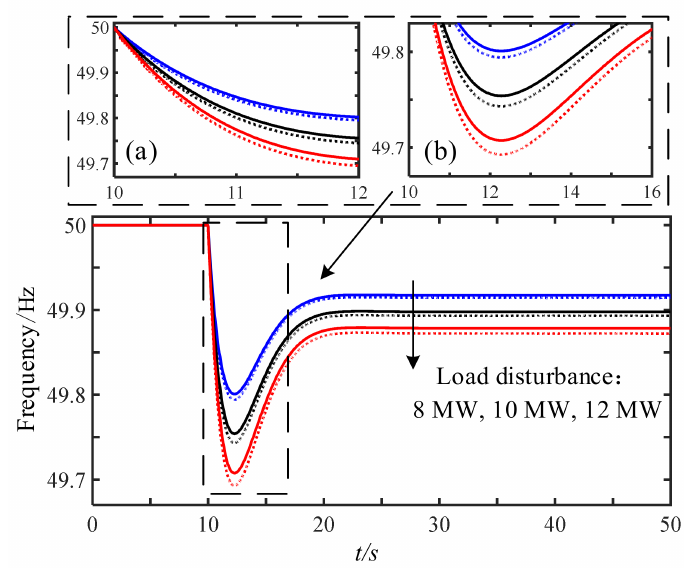
Figure 13. The influence with (solid line)/without (dashed line) asynchronous motors on the system frequency characteristics when the load disturbance keeps increasing. ( a ) The maximum rate of change of frequency; ( b ) The maximum frequency deviation.